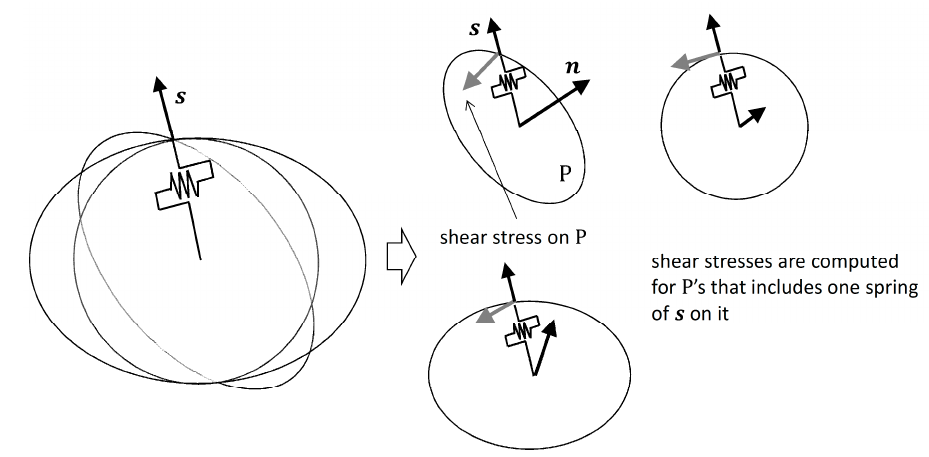
Figure 4. Schematic view of spring treatment used in original model; the spring in the 𝒔 direction is to be used in all planes 𝑃 that have springs in direction 𝒔 .